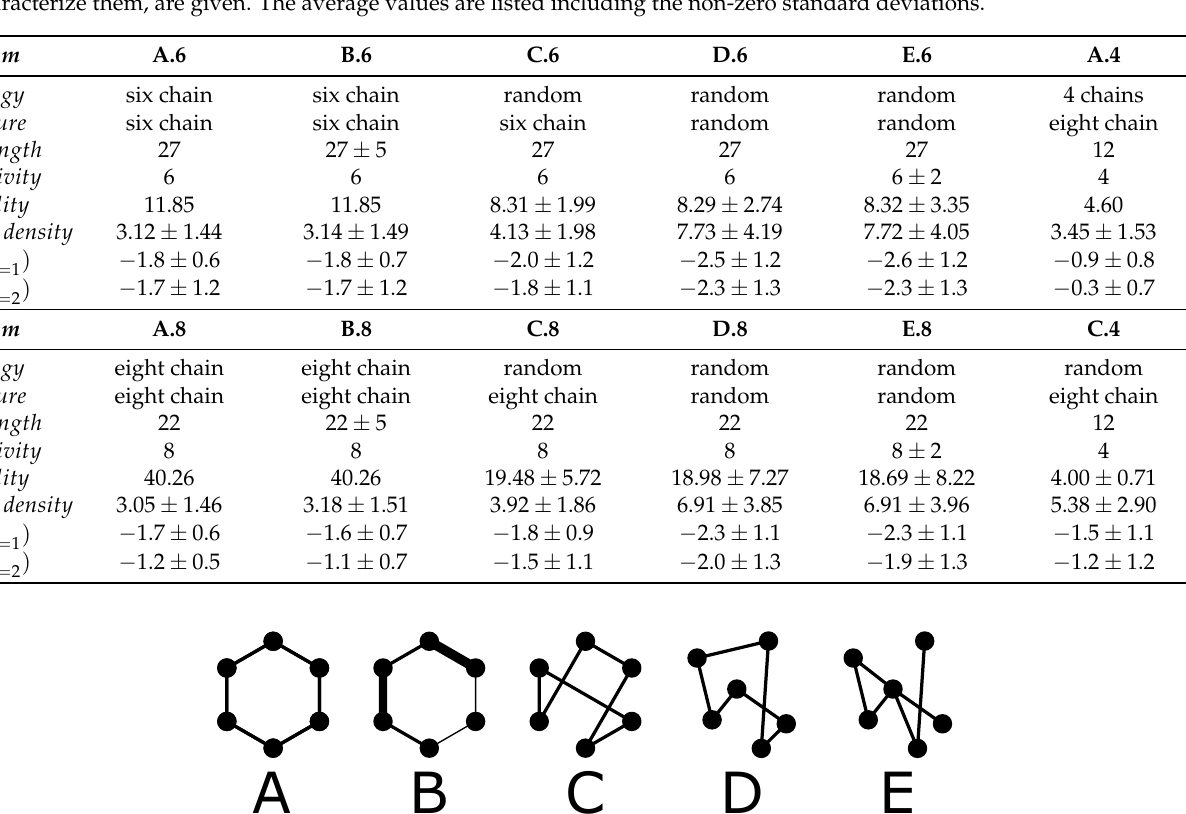
Table 1. Summary of the simulated system and results. The characteristics of the networks, as well as the different indicators to characterize them, are given. The average values are listed including the non-zero standard deviations.